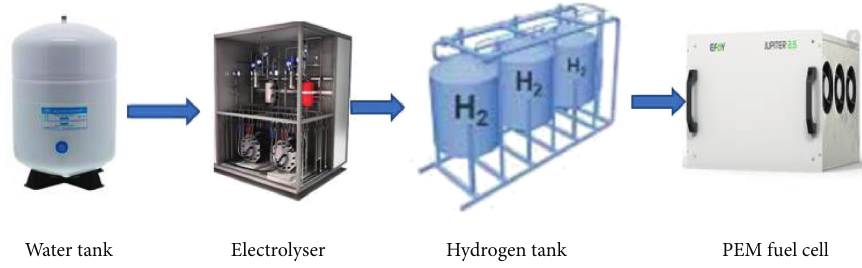
Figure 5: Block diagram of fuel